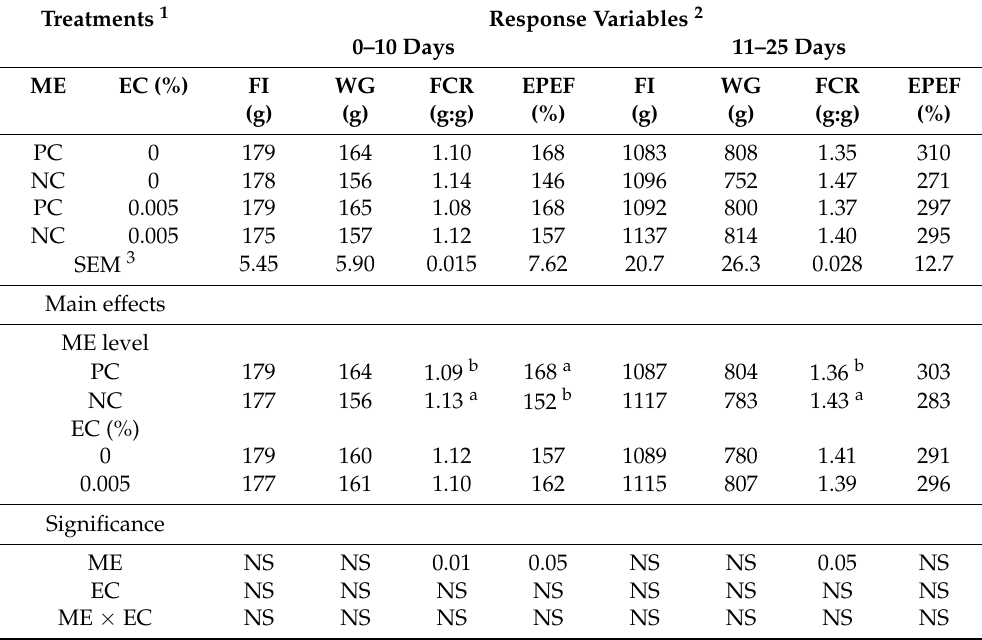
Table 2. Effect of dietary metabolizable energy (ME) level, enzyme cocktail (EC) supplementation, and their interaction on broiler performance in the starter (0–10 days) and grower (11–25 days)